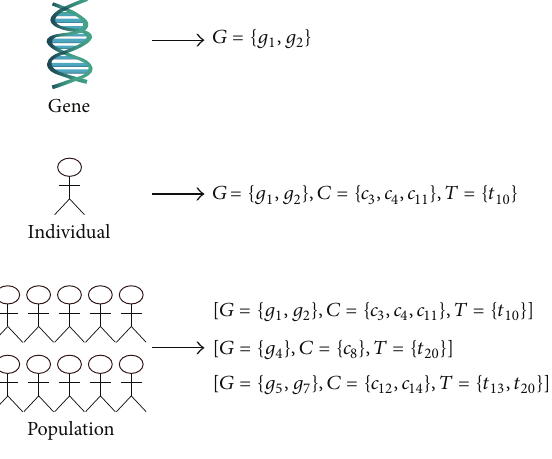
Figure 5: Genetic algorithm